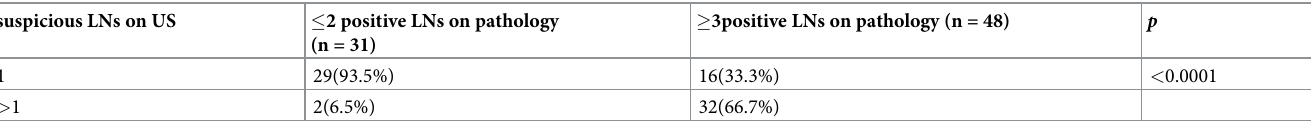
Table 1. Relativity of suspicious LNs on US with positive LNs burden on pathology. suspicious LNs on